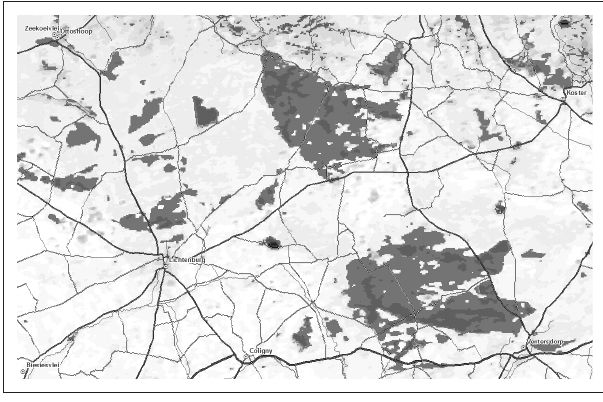
FIGURE 5: Classification of image data into 40 classes (clusters of data).